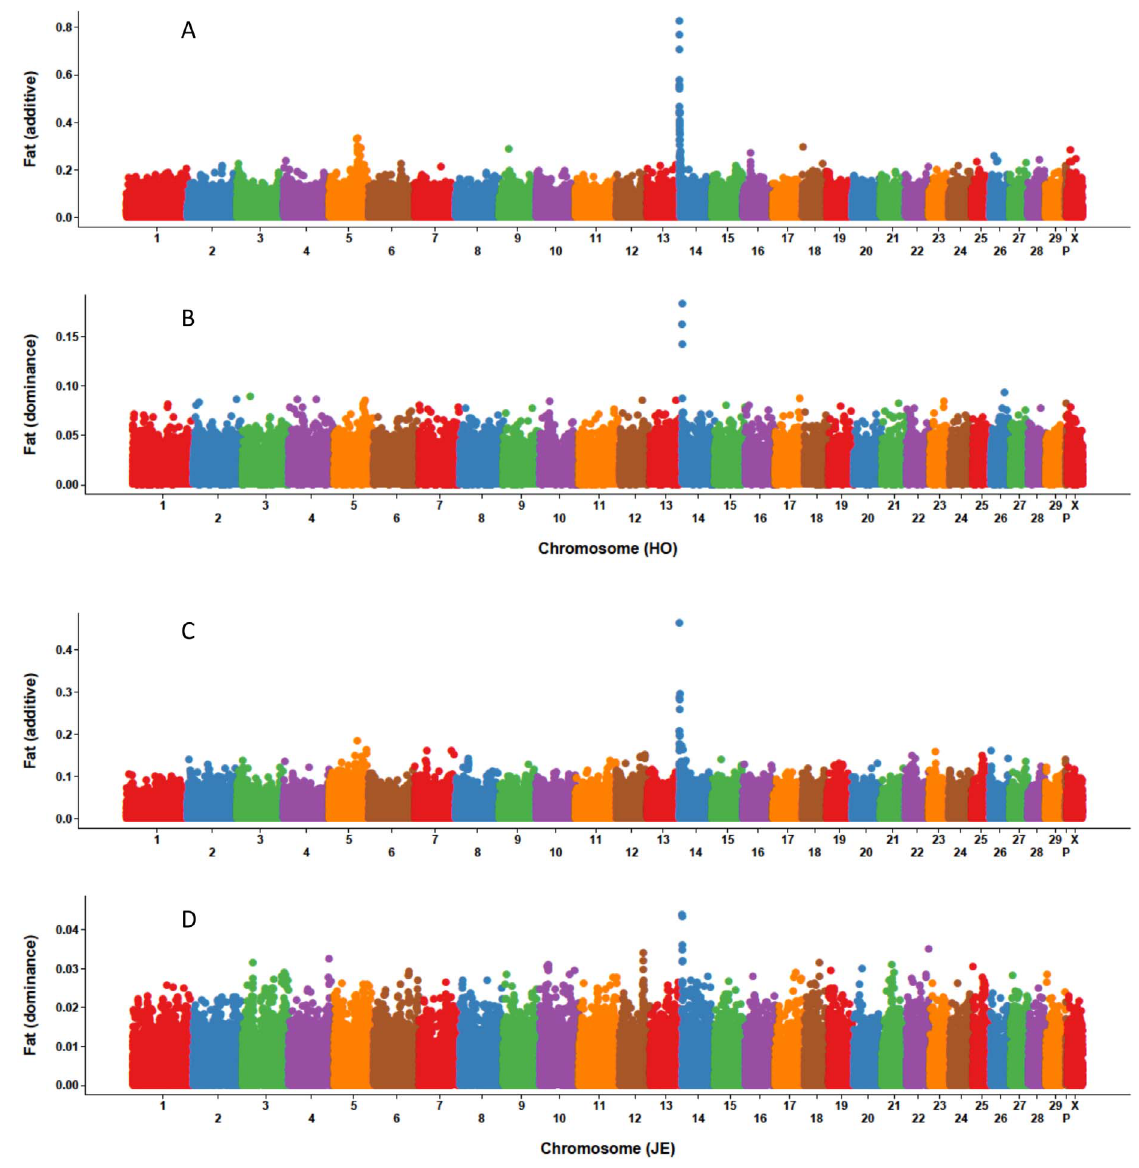
Figure 2. Size and location of marker additive and dominance effects for fat yield of Holsteins and Jerseys. Holstein additive (A) and dominance (B) effects and Jersey additive (C) and dominance (D) effects were estimated with a model that included additive and dominance (values) effects.